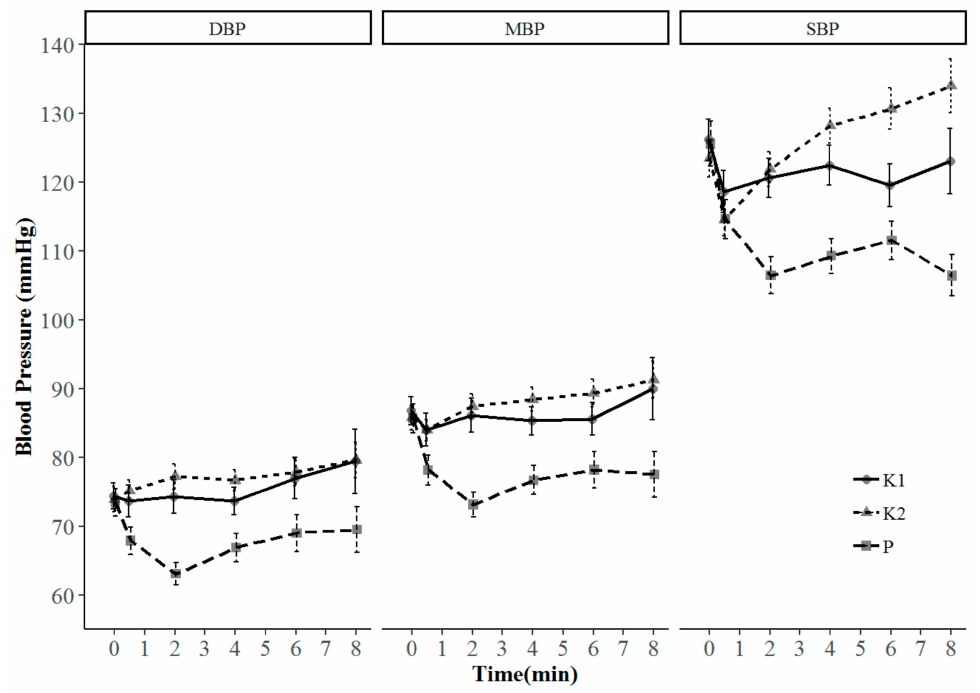
Figure 3. Blood pressure during the procedure. Data points represent the mean value (error bar: 95% confidence interval) measured at each time point. DBP, diastolic blood pressure; MBP, mean blood pressure; SBP, systolic blood